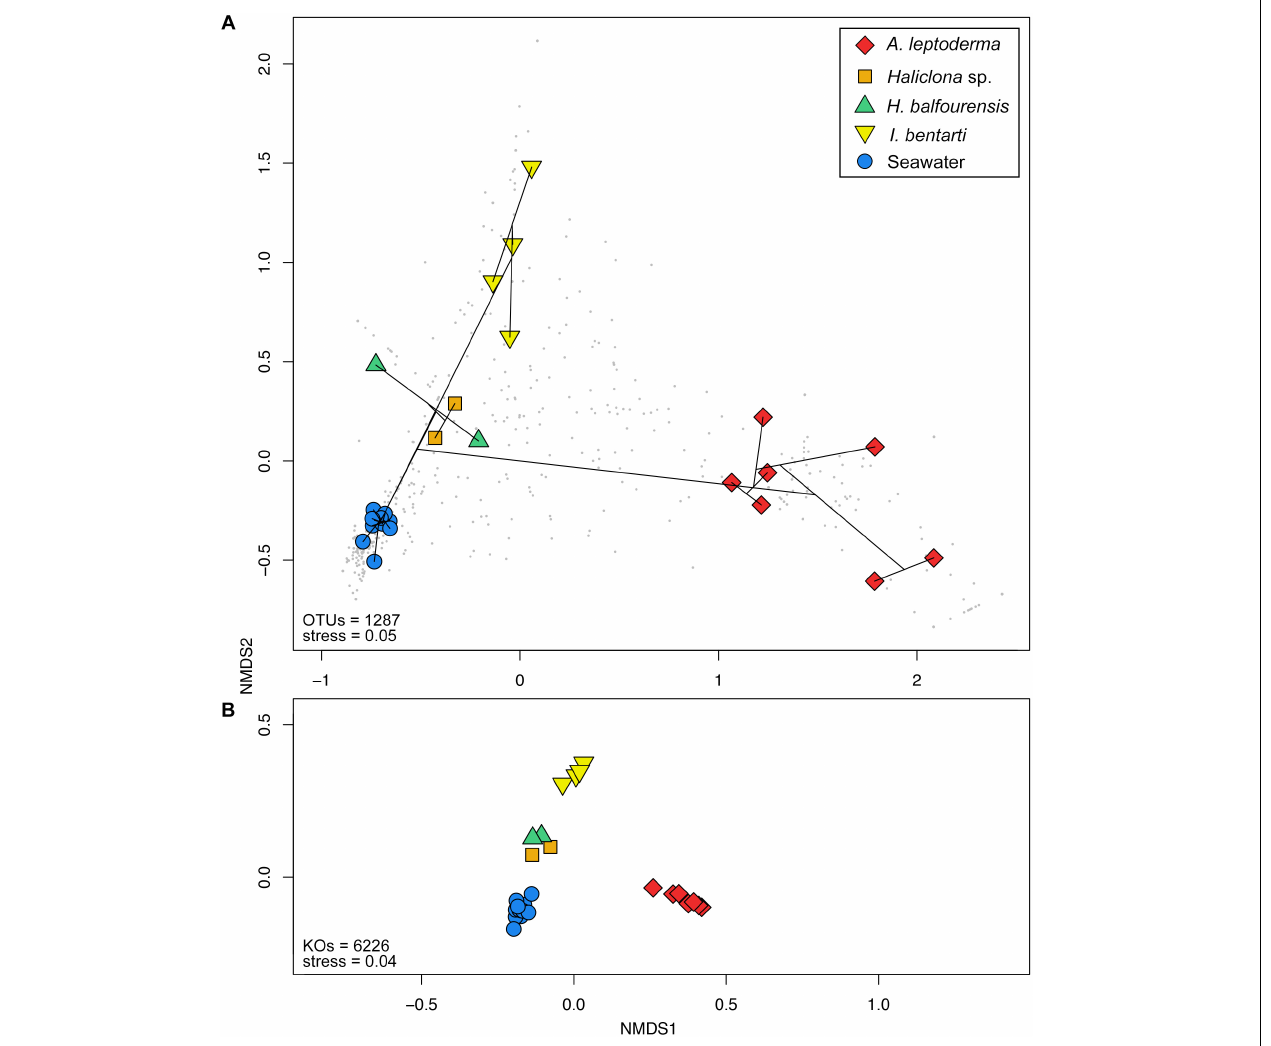
FIGURE 4 | Non-metric multidimensional scaling plots based on Bray–Curtis distances calculated from the (A) standardized 97% OTU table and (B) predicted KEGG Orthologs for each specimen and seawater samples. Colorization is based on the corresponding sponge taxonomy. Cluster information based on Bray–Curtis dissimilarities is added to (A) via the ordispider vegan function in R, in addition, taxonomic variables are added as gray dots to the